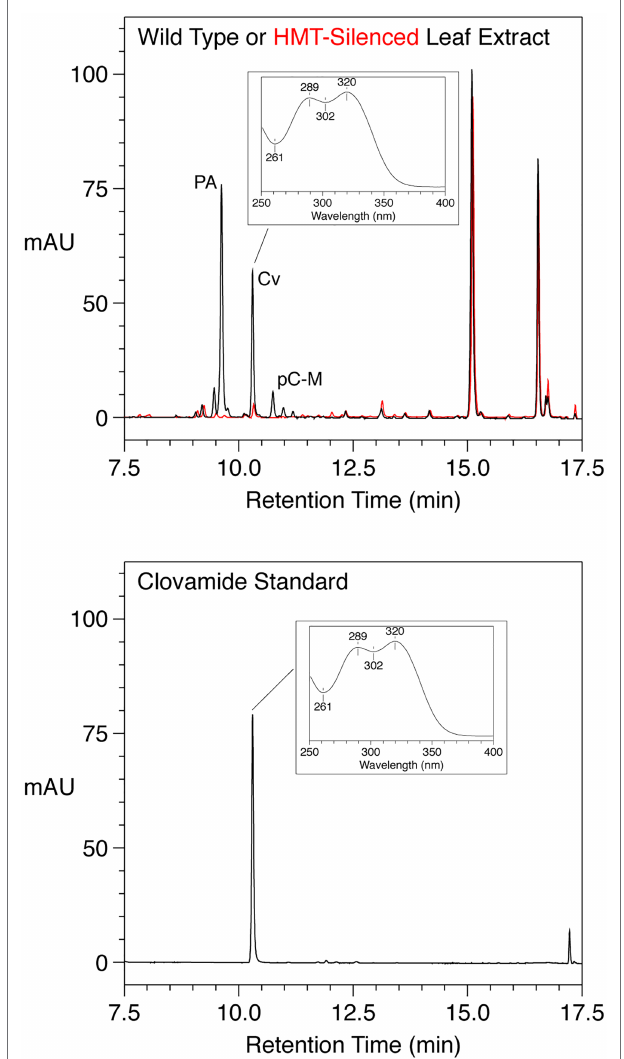
FIGURE 2 | HPLC Separation with PDA detection (250–500 nm, absorption in milli absorbance units) of phenolics from mature leaves from a wild type (black) or HMT-silenced (red) red clover plant (top panel) or a purchased clovamide standard (bottom panel). For leaf extracts, trans -phaselic acid (PA), - p -coumaroyl-malate (pC-M), and -clovamide (Cv) are indicated; major peaks at approximately 15 and 16.5 min were not identified but have UV absorption spectra consistent with flavonoids (data not shown). The UV absorption spectrum of the clovamide peak is shown in the